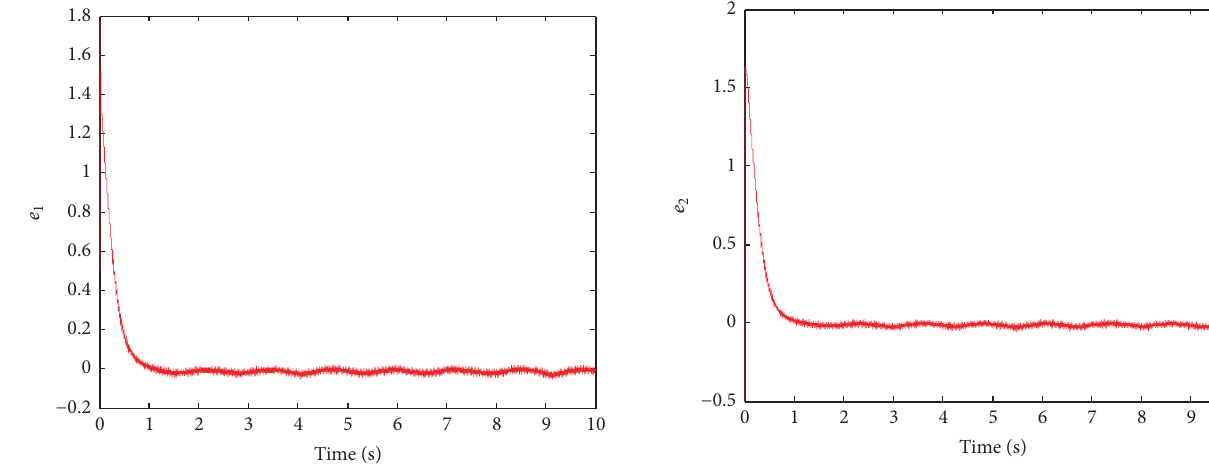
Figure 16: Tracking error 𝑒 1 of input signal 1.